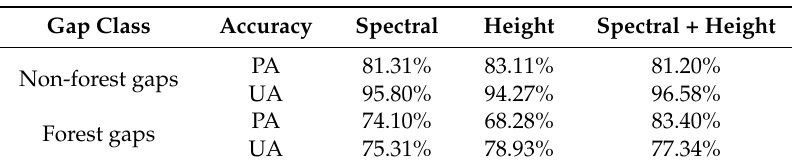
Table 2. Accuracy parameters of object-based canopy gap classifications by spectral, height, and both spectral and height information.